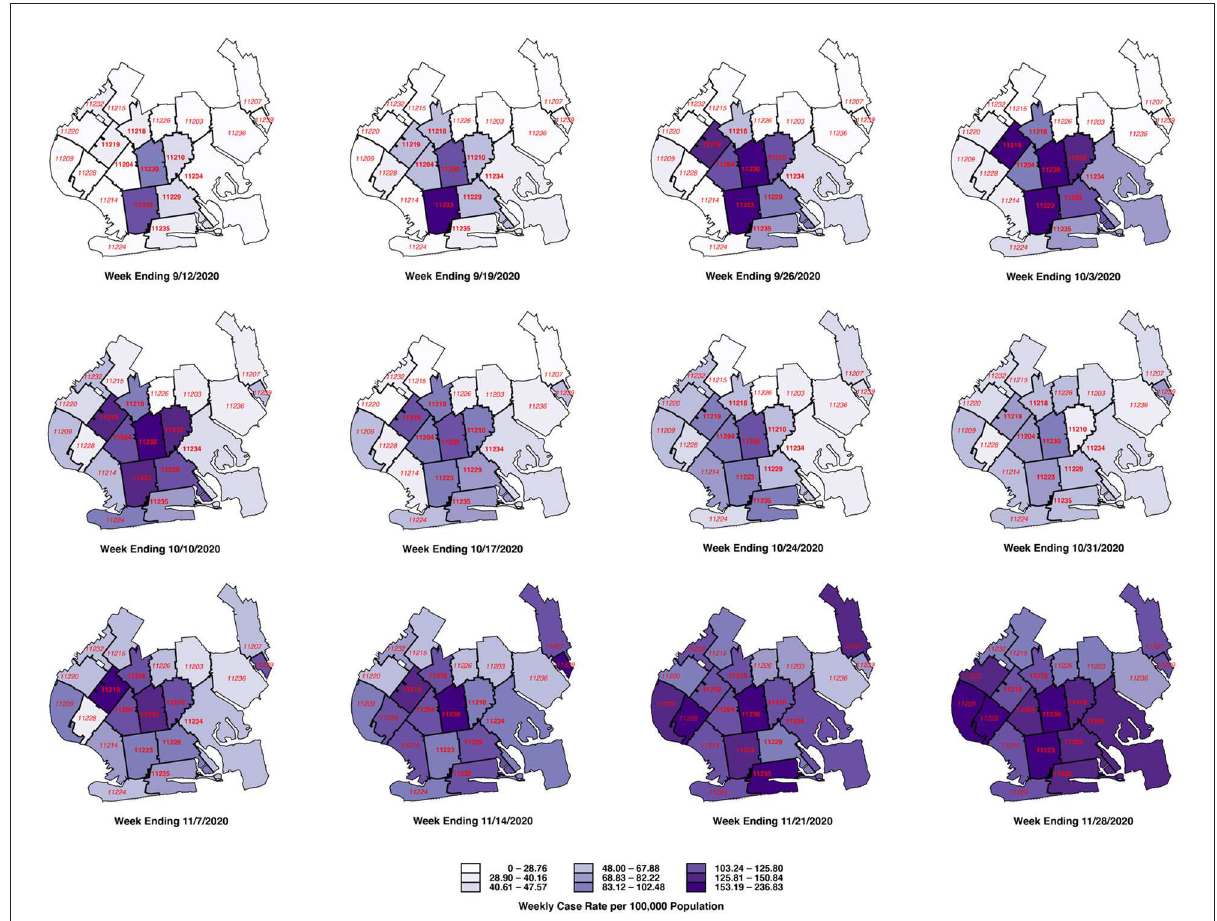
FIGURE6 Evolution of weekly case rate per 100,000 population among 21 ZCTAs in South Brooklyn, weeks ending 9/12 through 11/28/2020. For base map of New York City ZCTAs, see Ref.